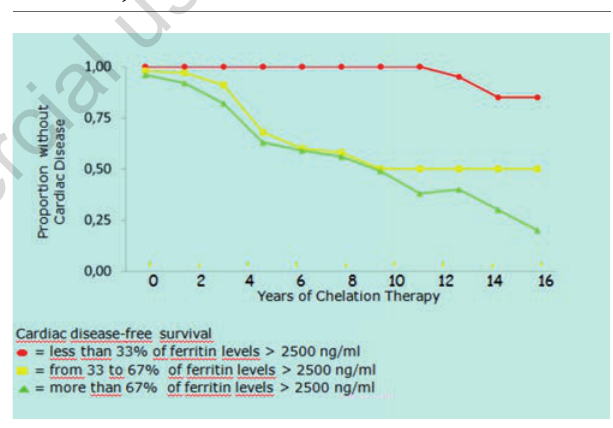
Figure 1. Hepcidin control of iron homeostasis: minor role in tha- lassemia major.